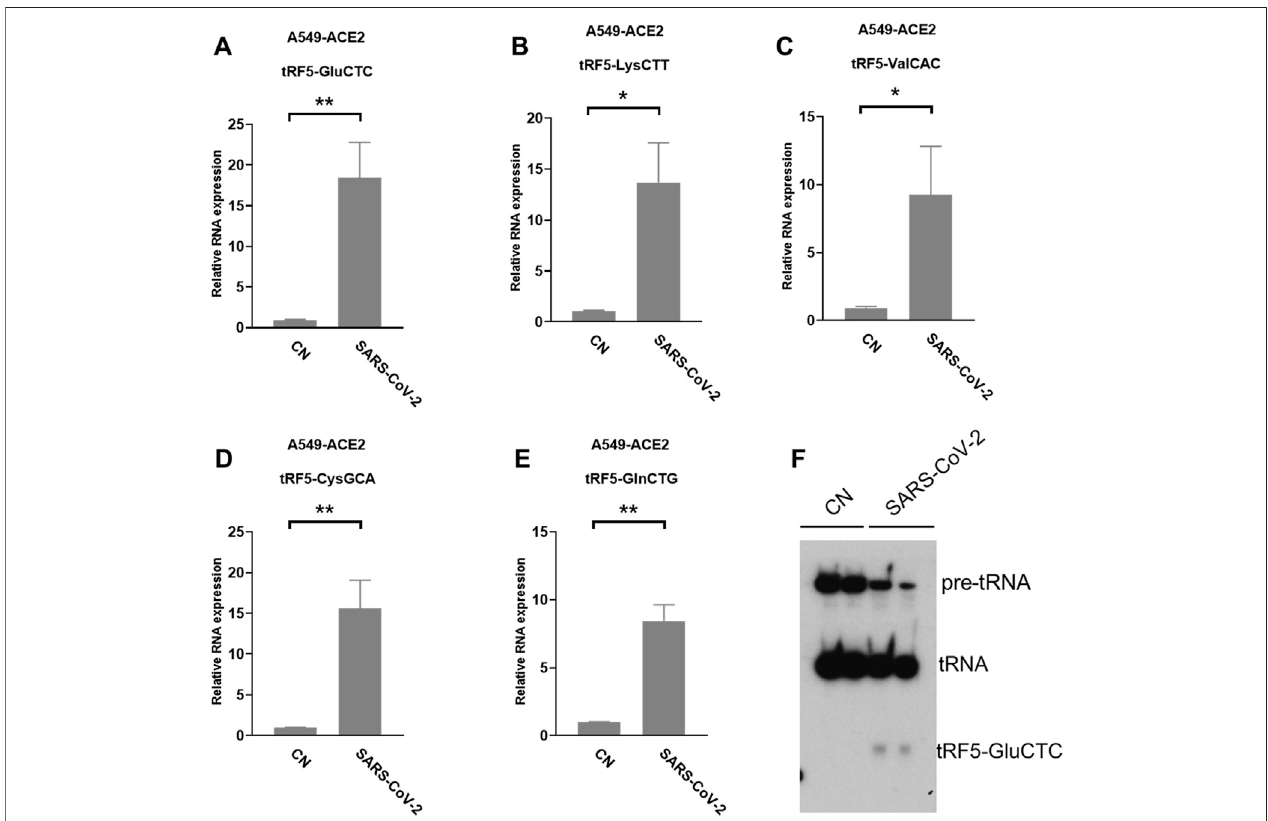
FIGURE4| SARS-CoV-2-impactedtRF5sinA549-ACE2cells. (A – E) A549-ACE2cellswereinfectedwithSARS-CoV-2atanMOIof0.1for4days,qRT-PCRwas performed to detect tRF5-GluCTC (A) , tRF5-LysCTT (B) , tRF5-ValCAC (C) , tRF5-CysGCA (D) , and tRF5-GlnCTG (E) . A northern blot was performed to detect tRF5- GluCTC (F) . Mock-infected cells (those without SARS-CoV-2 infection) were used as control (CN). Unpaired two-tailed t-tests were performed for statistical comparisons. Single and double asterisks represent p values of < 0.05 and < 0.01, respectively. Data, shown as means ± SE, are representative of three independent